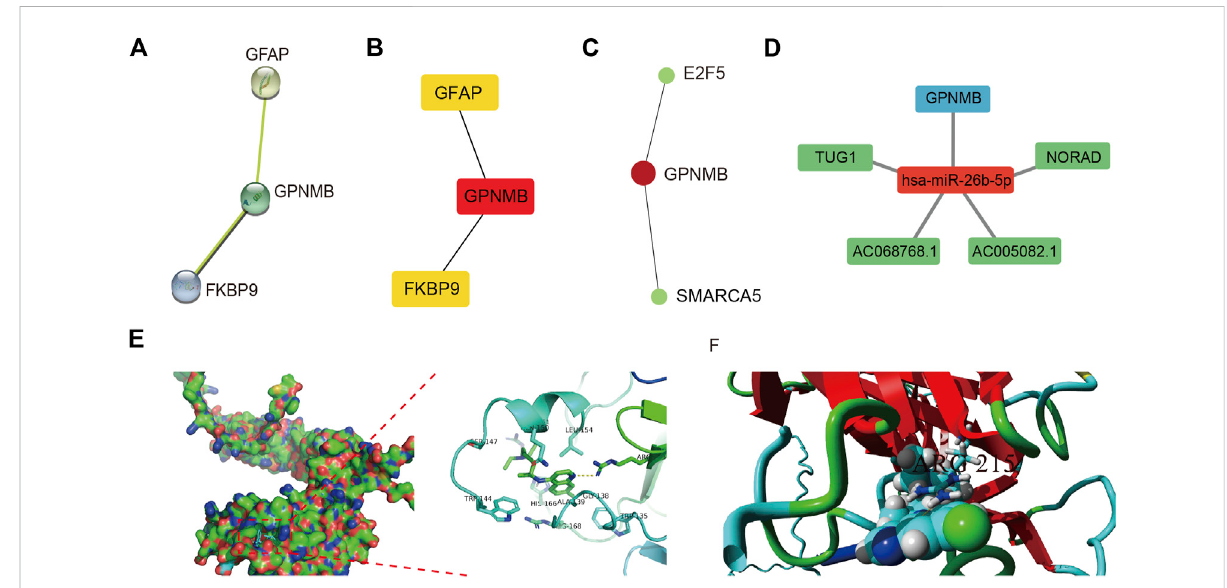
FIGURE 8 Protein-protein interaction (PPI) network, transcription factor (TF) correlation network, competing endogenous RNA (ceRNA) network and drug-molecular docking of the hub gene. (A) PPI network; each node represents a different gene. (B) Maximal clique centrality (MCC) value of each genewascalculated.Thedeeperthecolorthehigher,theMCCvalueofgenes. (C) TFcorrelationnetworkofthehubgene.Redrepresentsgenesand green represents TFs. (D) ceRNA network of the hub gene. Red represents miRNA, blue represents mRNA, and green represents lncRNA. (E) Docking results between GPNMB and chloroquine in Autodock. Hydrogen bond between two was marked in yellow dotted line. (F) Docking results of YASARA. Binds marked in yellow represent hydrogen